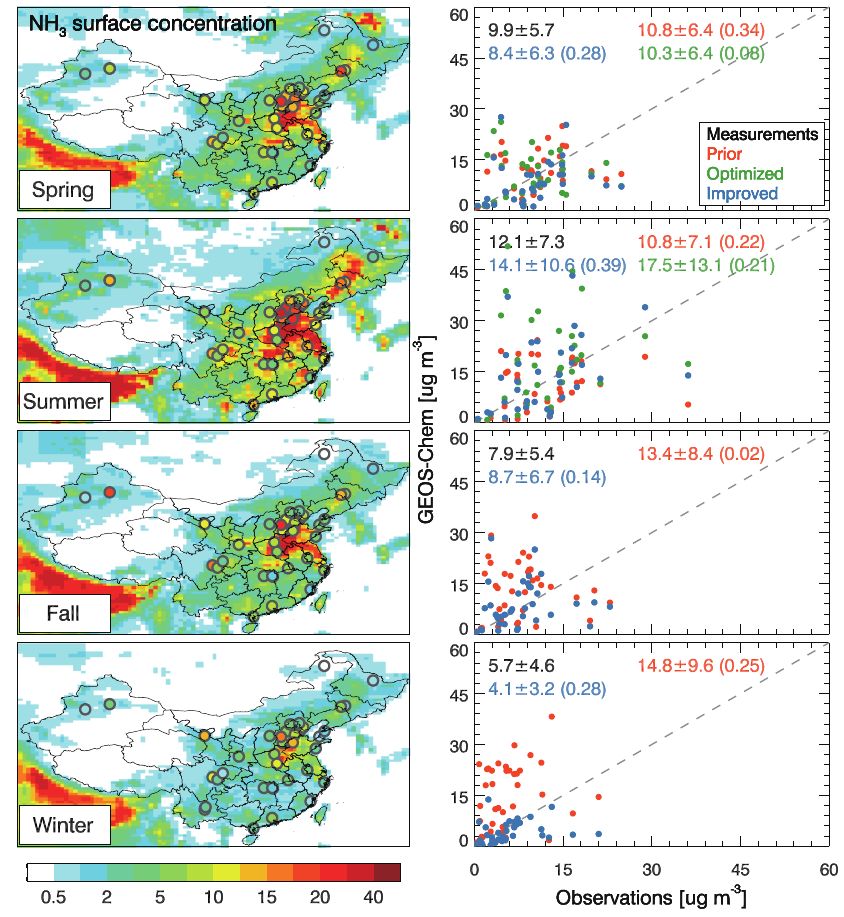
Figure 9. The same as Fig. 8, but for surface NH 3